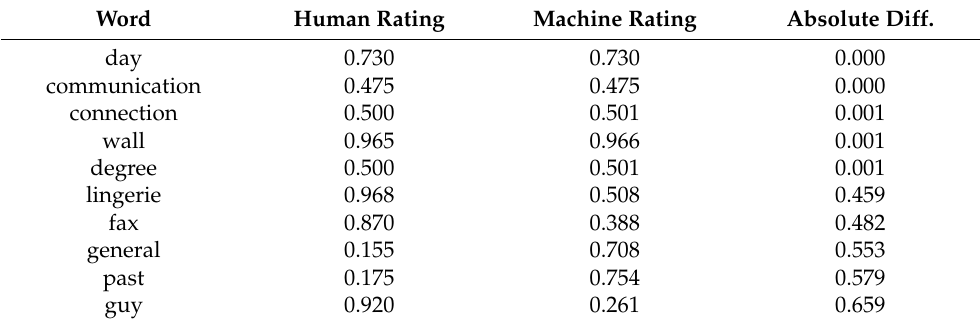
Table 2. Discrepancy between machine and human estimates (both minimum and maximum differ- ences with respect to